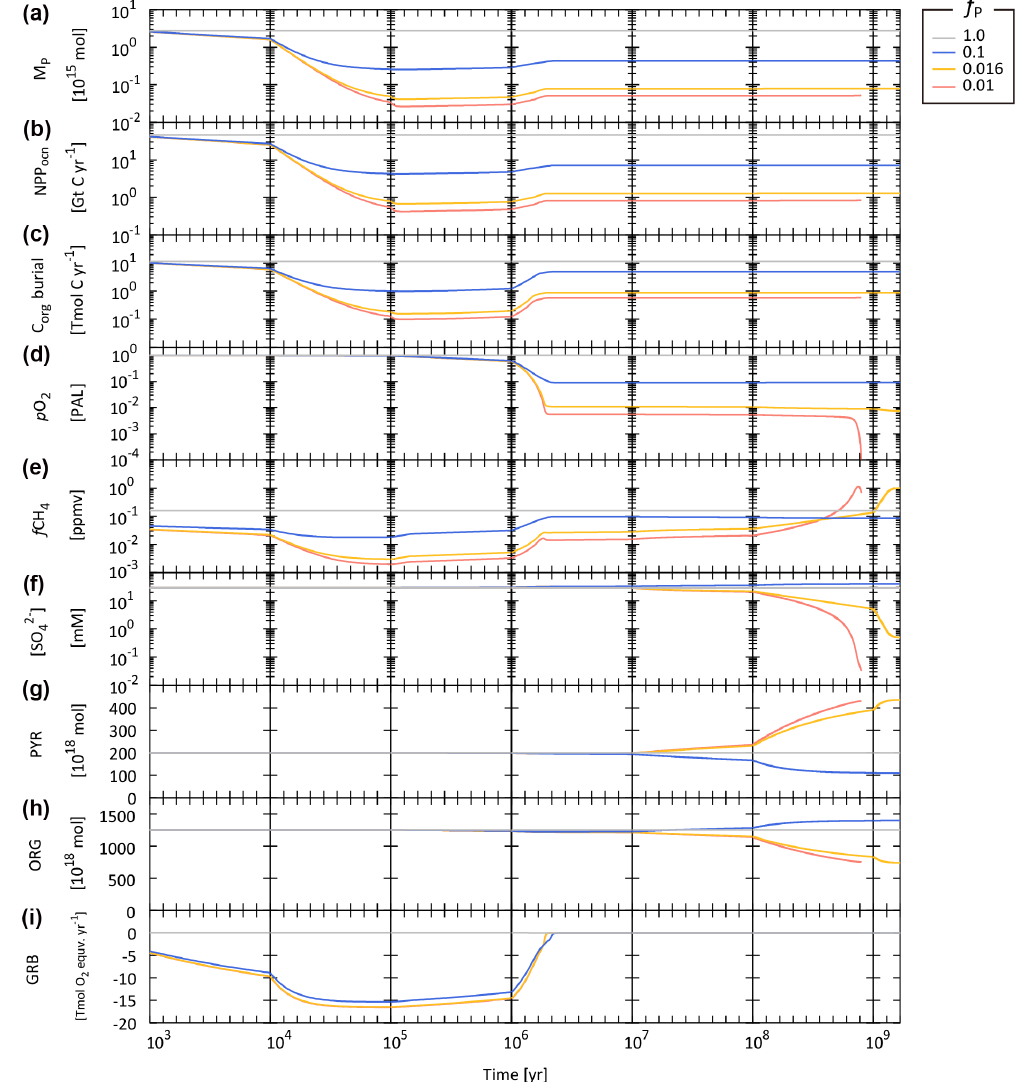
Figure 18. Biogeochemical responses obtained from the CANOPS-GRB model with different values of P availability, f P . (a) Oceanic phosphate inventory, M P . (b) Oceanic net primary production (NPP ocn ). (c) Burial rate of organic carbon (C org ) in marine sediments. (d) Atmospheric partial pressure of O 2 . PAL stands for present atmospheric level. (e) Atmospheric CH 4 mixing ratio. (f) Sulfate concentration in the surface ocean layer. (g) Sedimentary reservoir size of pyrite sulfur (PYR). (h) Sedimentary reservoir size of organic carbon (ORG). (i) Global redox budget (GRB). For the f P = 1% run (red line), the calculation stopped when the atmospheric O 2 level decreased to ∼ 10 − 5 PAL due to the numerical